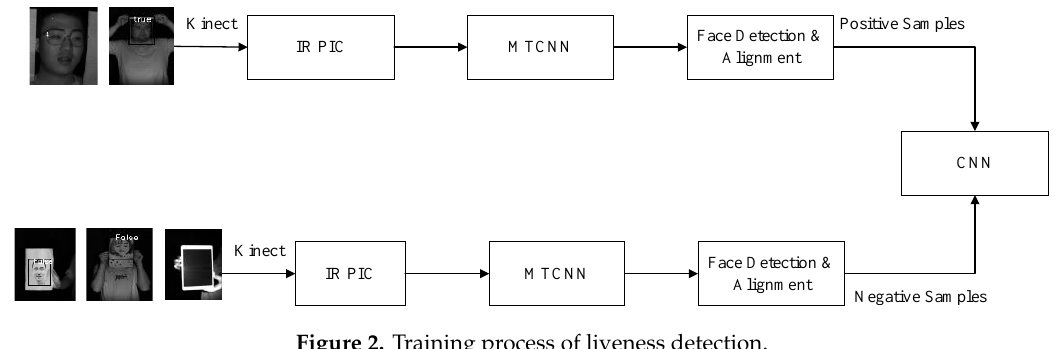
Figure 2. Training process of liveness detection.